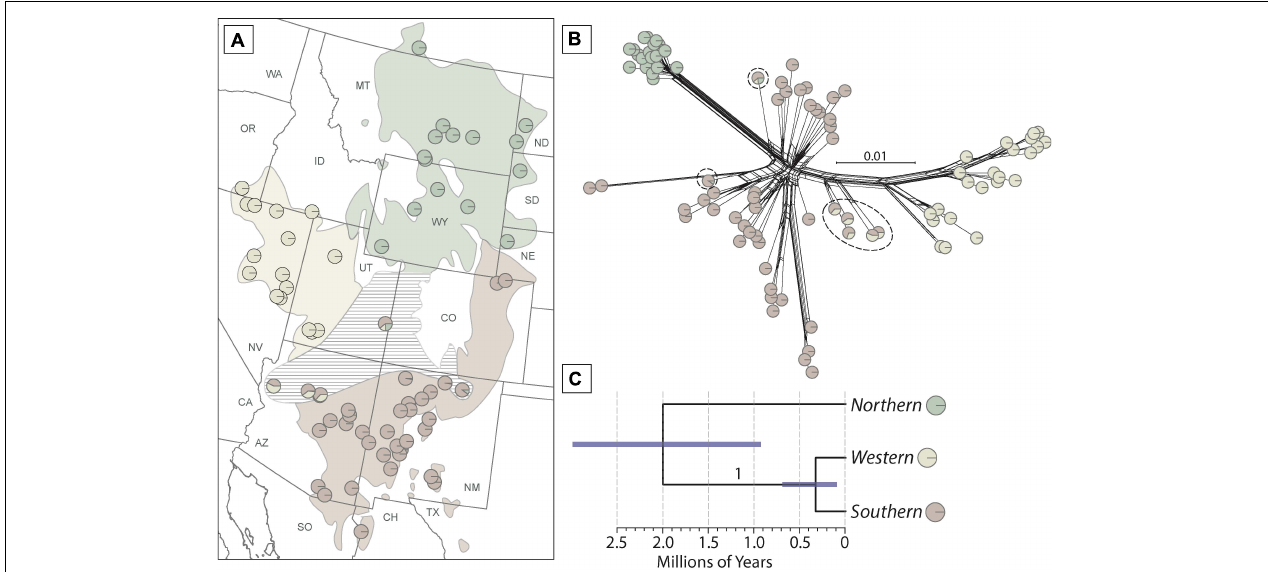
FIGURE 3 | Phylogeographic analysis supports at least three populations within Phrynosoma hernandesi . (A) Population structure analysis with the optimal K = 3 model estimated with ADMIXTURE. Each sample is represented by a pie-chart with colors indicating ancestry proportions. Hatching indicates an area where admixed samples are found. (B) Network analysis inferred from the program SplitsTree with admixture proportions assigned to each sample. Admixed samples are encircled with dashed lines. (C) A species tree analysis inferred from the unlinked and biallelic SNP data for the three populations. The posterior probability value supporting the west and south populations as a clade is 1.0. Branch lengths (error bars are 95% highest posterior densities) were converted to absolute time assuming a rate of 7.7 × 10 − 10 substitutions per site per year (see “Materials and Methods” section for details).